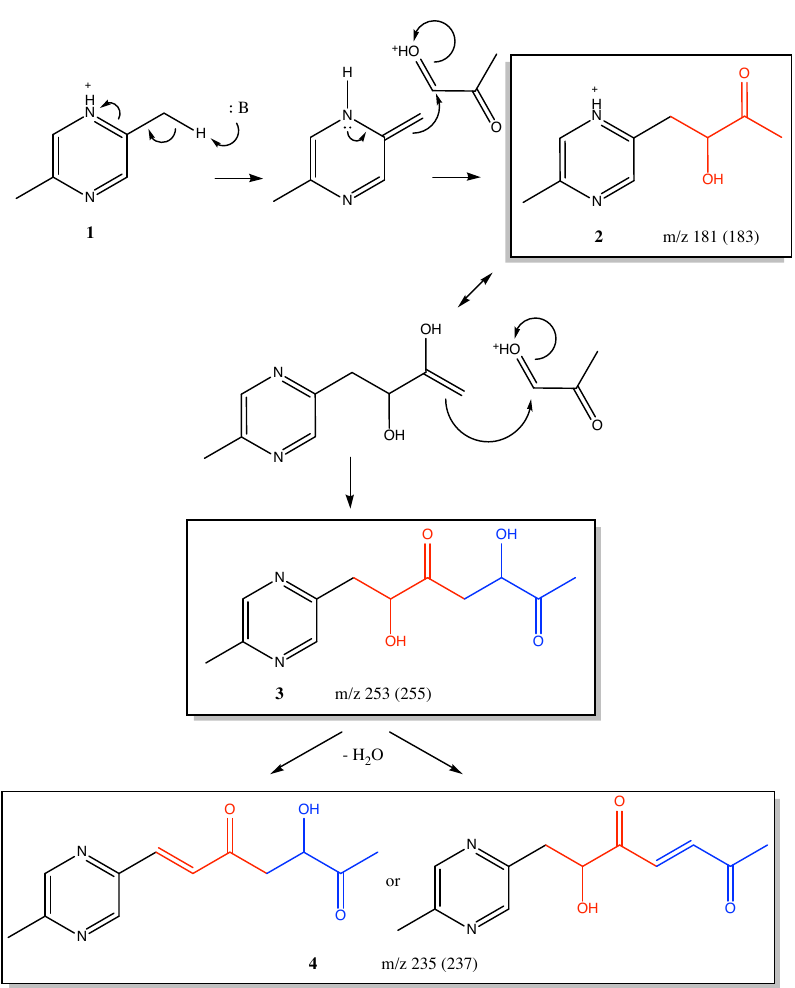
Scheme 2. Proposed formation mechanism of pyrazine-based chromophores (2), (3), and (4) with m/z 181, 253, and 235 observed by APCI from 2,5-dimethylpyrazine and methylglyoxal. Masses expected and observed in samples prepared with 15 N are given in parentheses. Addition of methylglyoxal here follows the mechanism presented in De Haan et al. (2011) for oligomerization of imidazole products in this same system. Red and blue are used to highlight individual and intact methylglyoxal units in the products that were directly observed by APCI-MS. Additional possible structures for m/z 253 and 235 are shown in Table